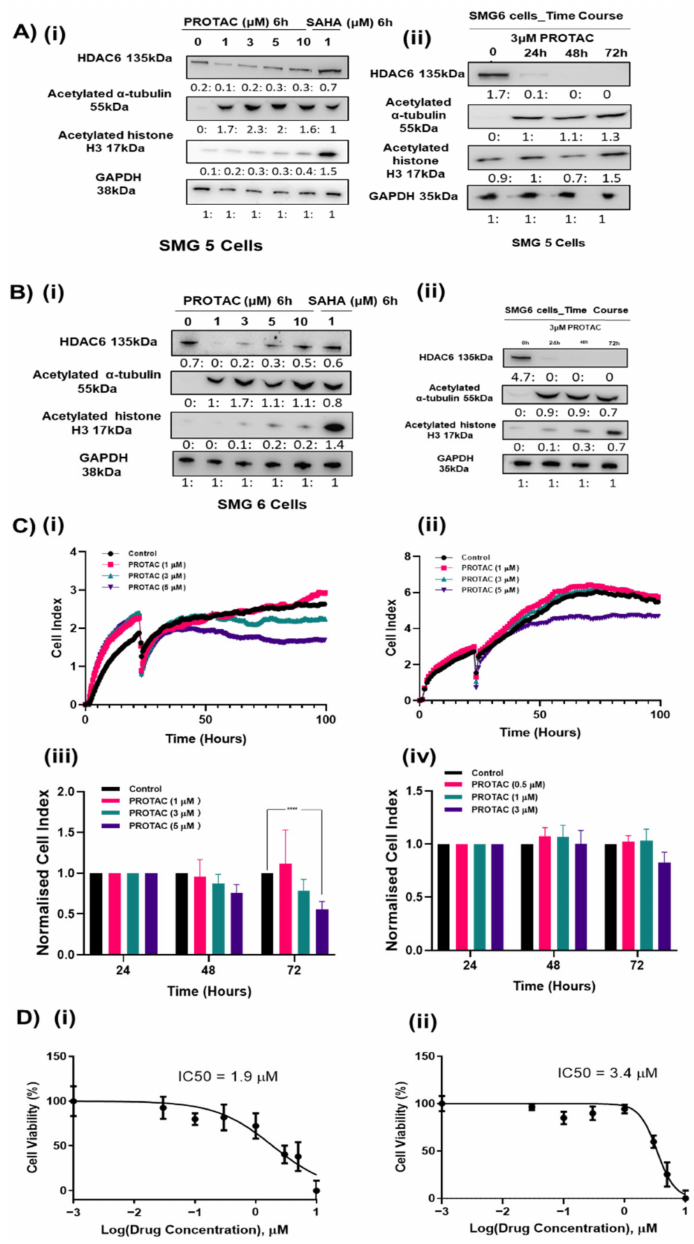
Figure 5. E ffi cacy of PROTAC treatment on ovarian cancer cell growth. ( A ) SMG 5 cells were treated by PROTAC for 6 h. SAHA, a pan inhibitor of HDACs, was used as a positive control. Degradation e ffi cacy and selectivity of PROTAC was tested by western blot. GAPDH was used as a loading control. Degradation e ffi cacy of 3 µ M PROTAC was tested over time. Experiments performed at least n = 2. Uncropped Western Blots are available in Figures S10 and S11 ( B ) SMG 6 cells were treated by PROTAC for 6 h. Degradation e ffi cacy and selectivity of PROTAC was tested by western blot. GAPDH was used as a loading control. Degradation e ffi cacy of 3 µ M PROTAC was tested over time. Experiments performed at least n = 2. Uncropped Western Blots are available in Figures S12 and S13. ( C ) / ( i) ,( ii ) Representative graphs from the real time xCELLigence proliferation system comparing growth profiles of SMG cells following treatment with PROTAC. ( C ) / ( iii) ,( iv ) Cell index values were normalized to both 24 h and control, observing the rate of proliferation (24–96 h). Wells were analyzed in duplicate, and three biological replicates were performed to validate results. Experiments were analyzed by a two-way ANOVA. **** p < 0.0001. Error bars represent SEM. ( C ) / ( i) ,( iii ) SMG5, ( C ) / ( ii) ,( iv ) SMG6. ( D ) E ff ect on cell viability after treated by PROTAC for 48 h was determined by MTT assay ( n =